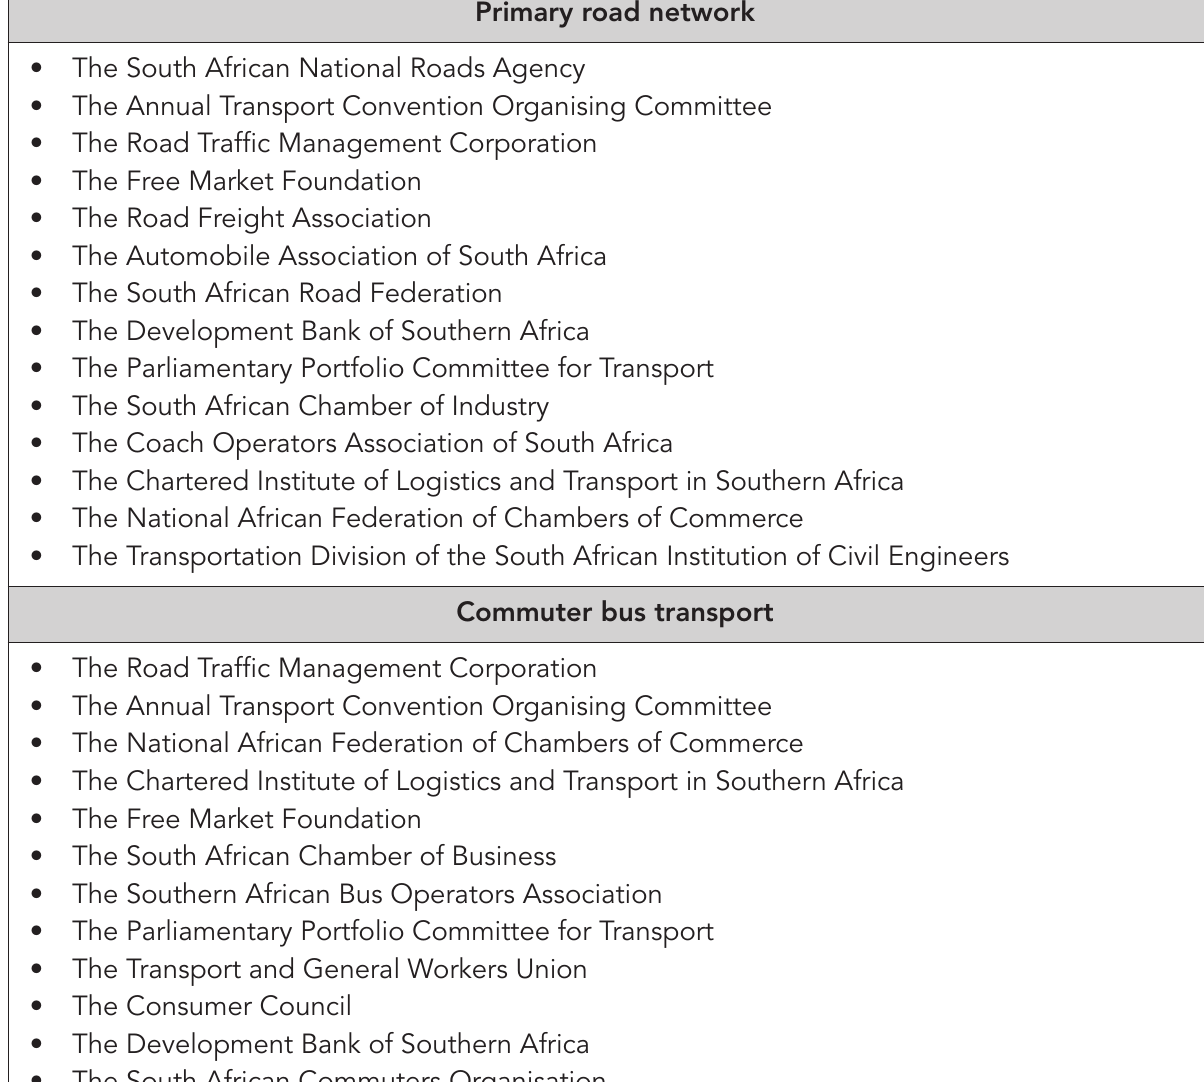
Table A3: Organisations polled in respect of the impact analysis of transport policy for primary roads and commuter bus transport Source: Compiled for purposes of this